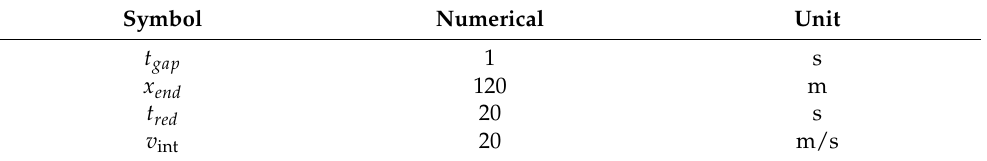
Table 2. Input parameters for GA optimization of deceleration stopping.